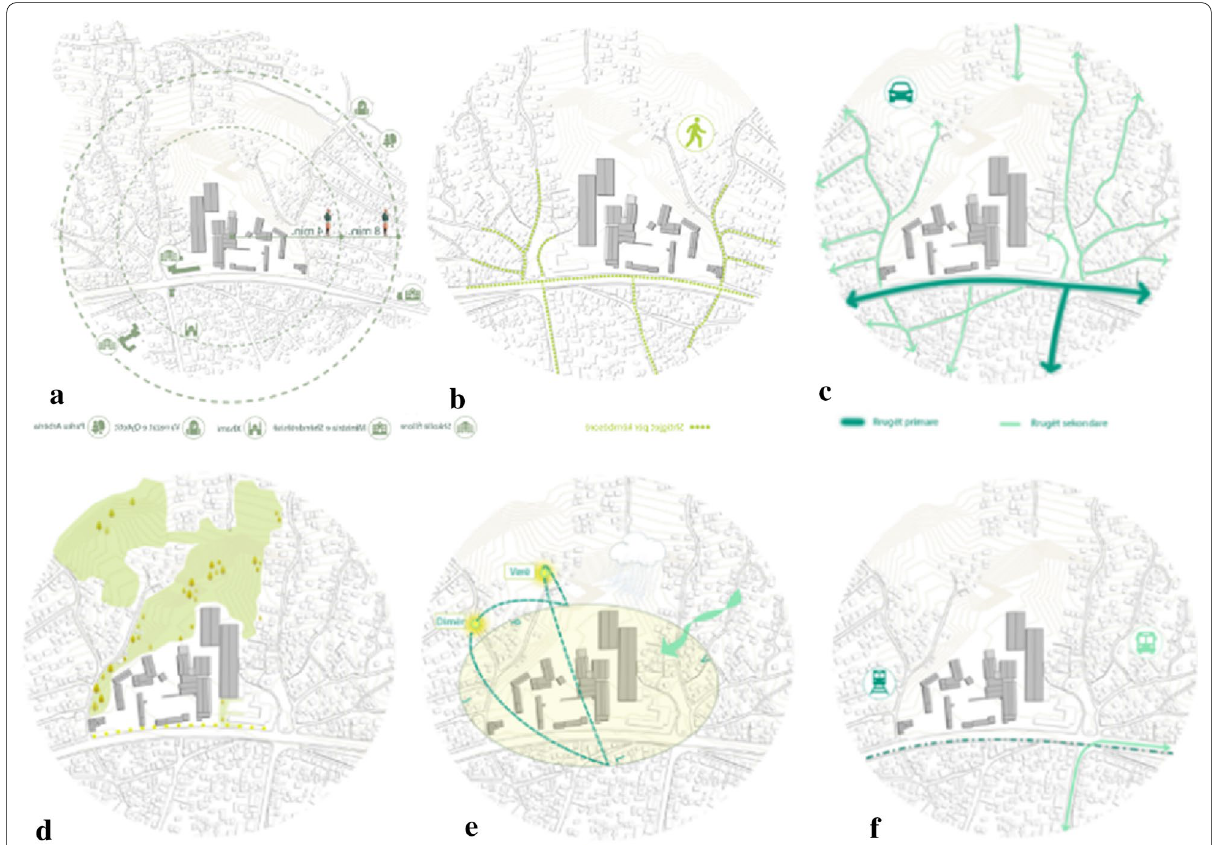
Fig. 4 Site analysis: a walking distance, b pedestrian route, c vehicle route, d Green areas, e wind & sun exposure, f public transport route (author: